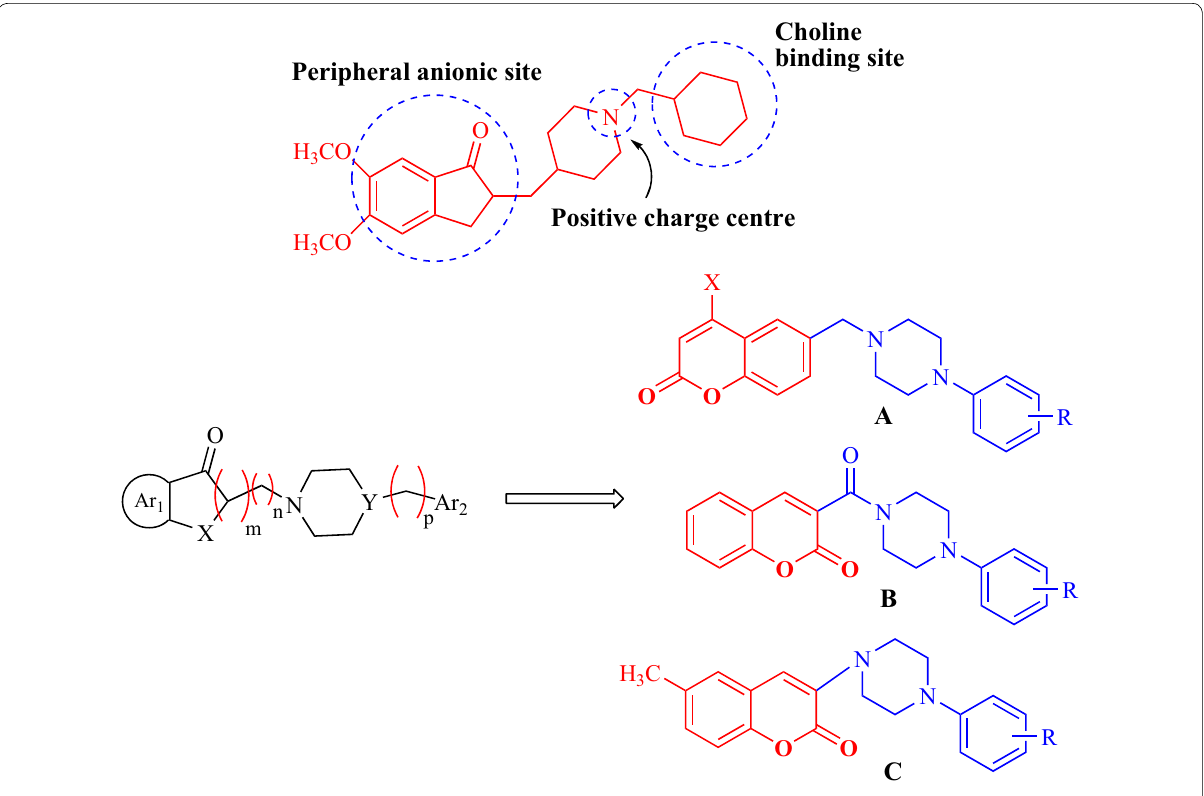
Fig. 14 Design strategy of the target compounds of series A, B and C